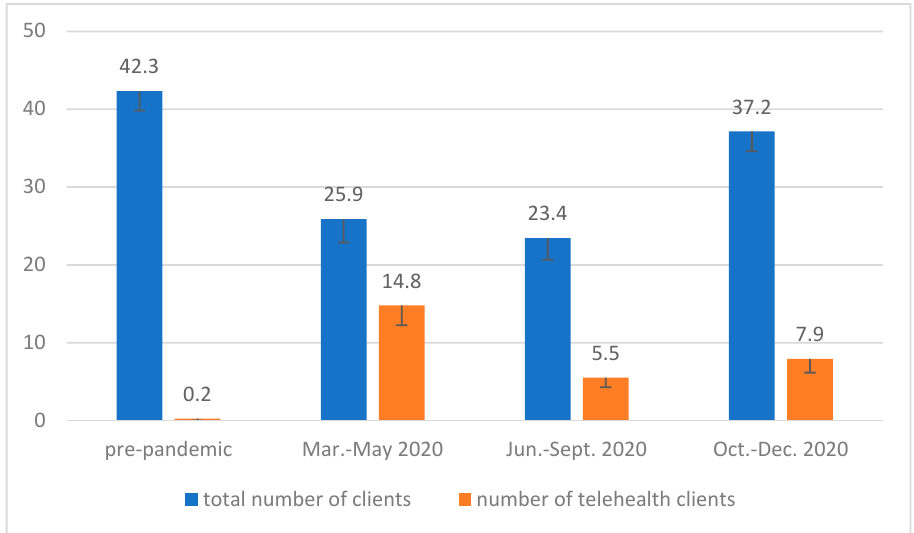
Figure 1. Total number of clients and number of telepractice clients in a typical week before the pandemic and during the pandemic from the December 2020 survey ( n = 51).